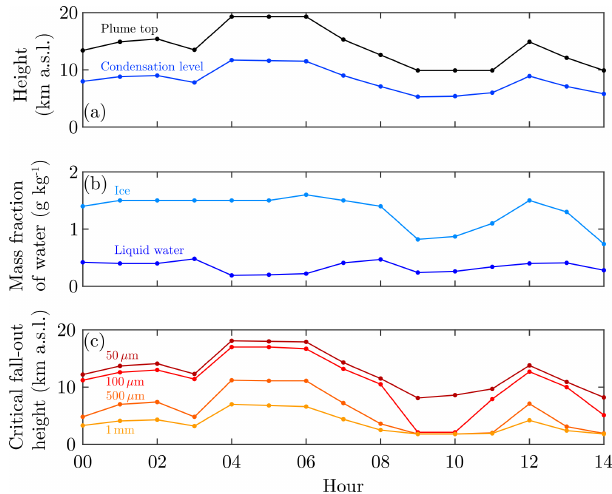
Figure A1. Model predictions of the properties of the Grímsvötn plume on 22 May 2011. (a) Plume-top height and condensation level in the plume. (b) Maximum mass fractions of liquid water and water ice. (c) Critical height at which particles fall out of the plume for particles of 50µm, 100µm, 500µm, and 1mm